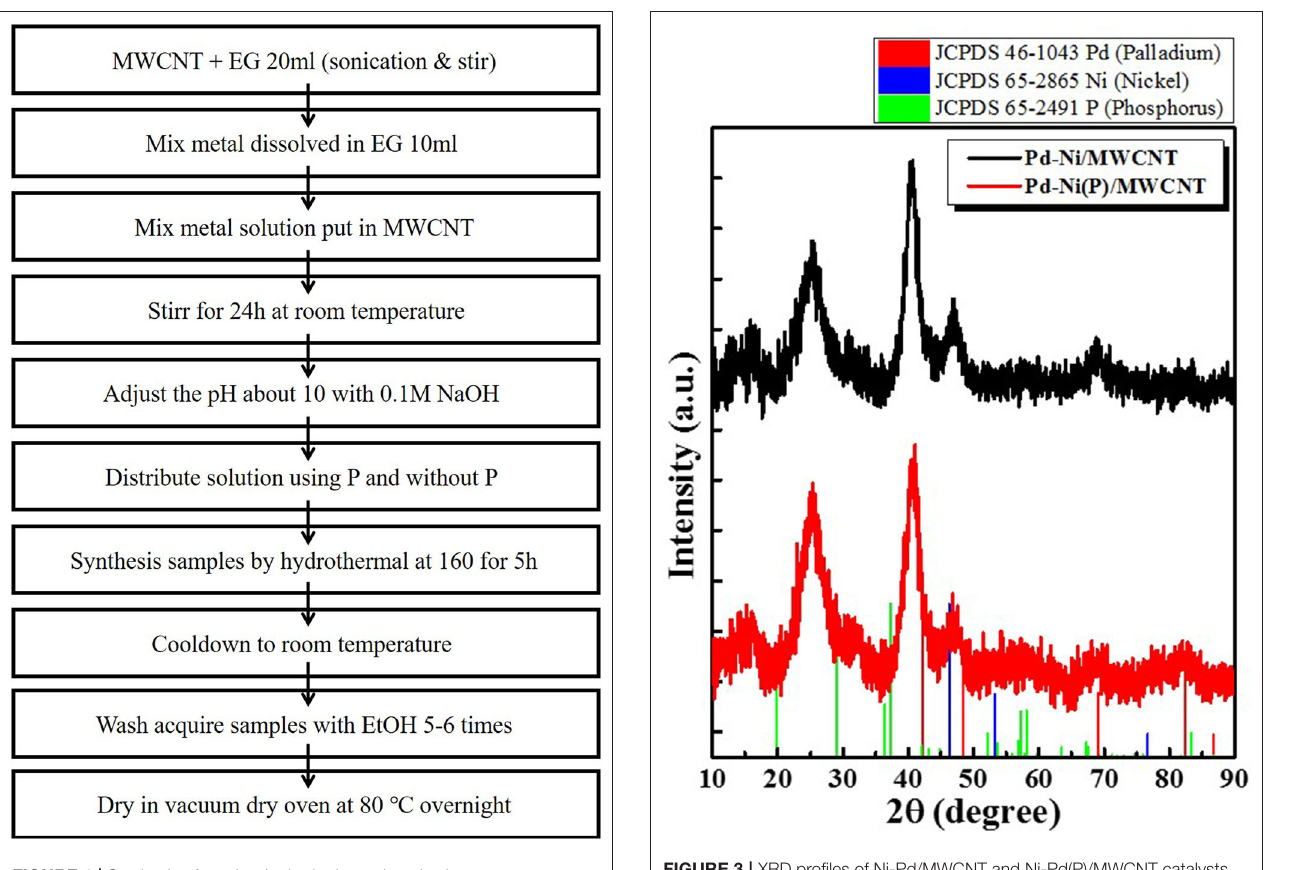
FIGURE 1 | Synthesis of catalyst by hydrothermal method.